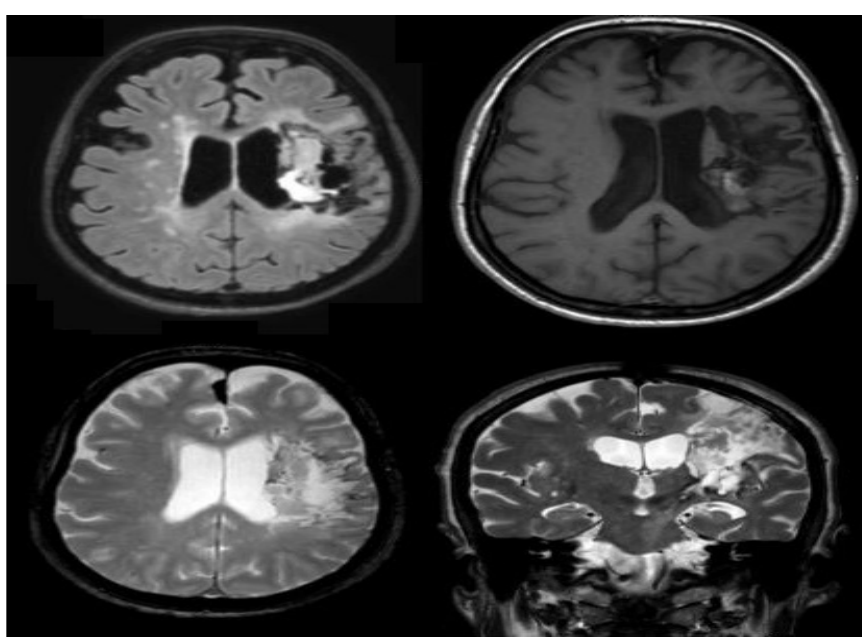
Figure 1. Patient’s brain damage evidenced by MRI scan.